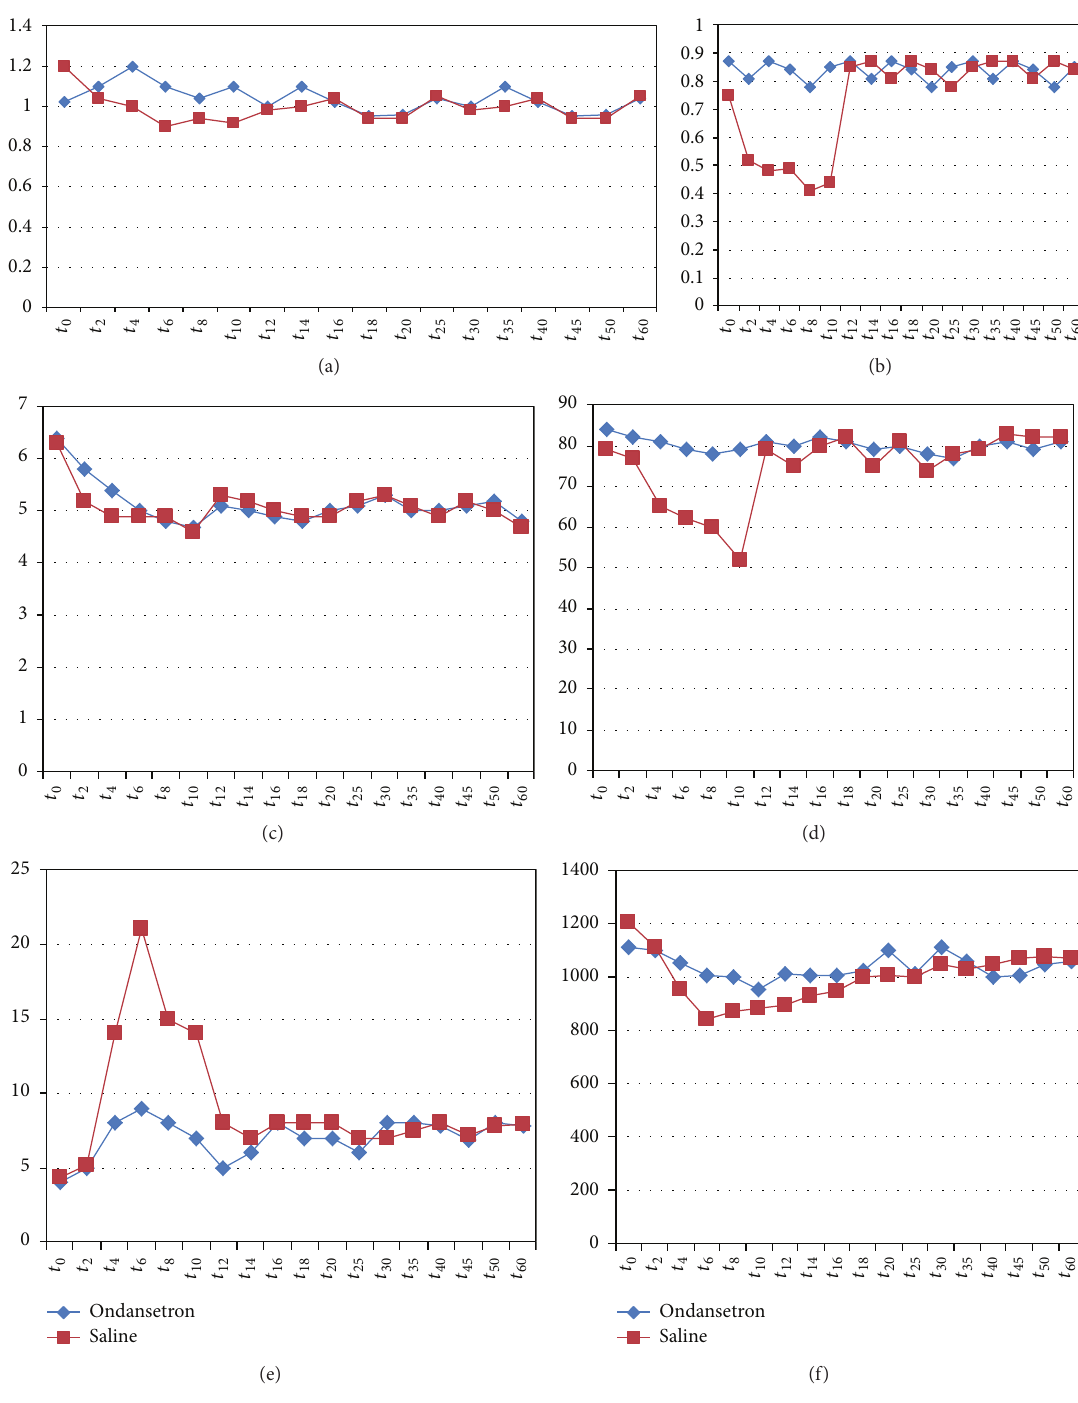
Figure 6: (a) Trends of mean 𝑑𝑃/𝑑𝑡 MAX. (b) Trends of mean cardiac cycle efficiency (CCE). (c) Trends of cardiac output (L ⋅ min −1 ). (d) Trends of mean stroke volume (mL ⋅ min −1 ). (e) Trends of mean pulse pressure variation. (f) Trends of mean systemic vascular resistance (dynes ⋅ s ⋅ cm −5 ). 𝑡 : time in